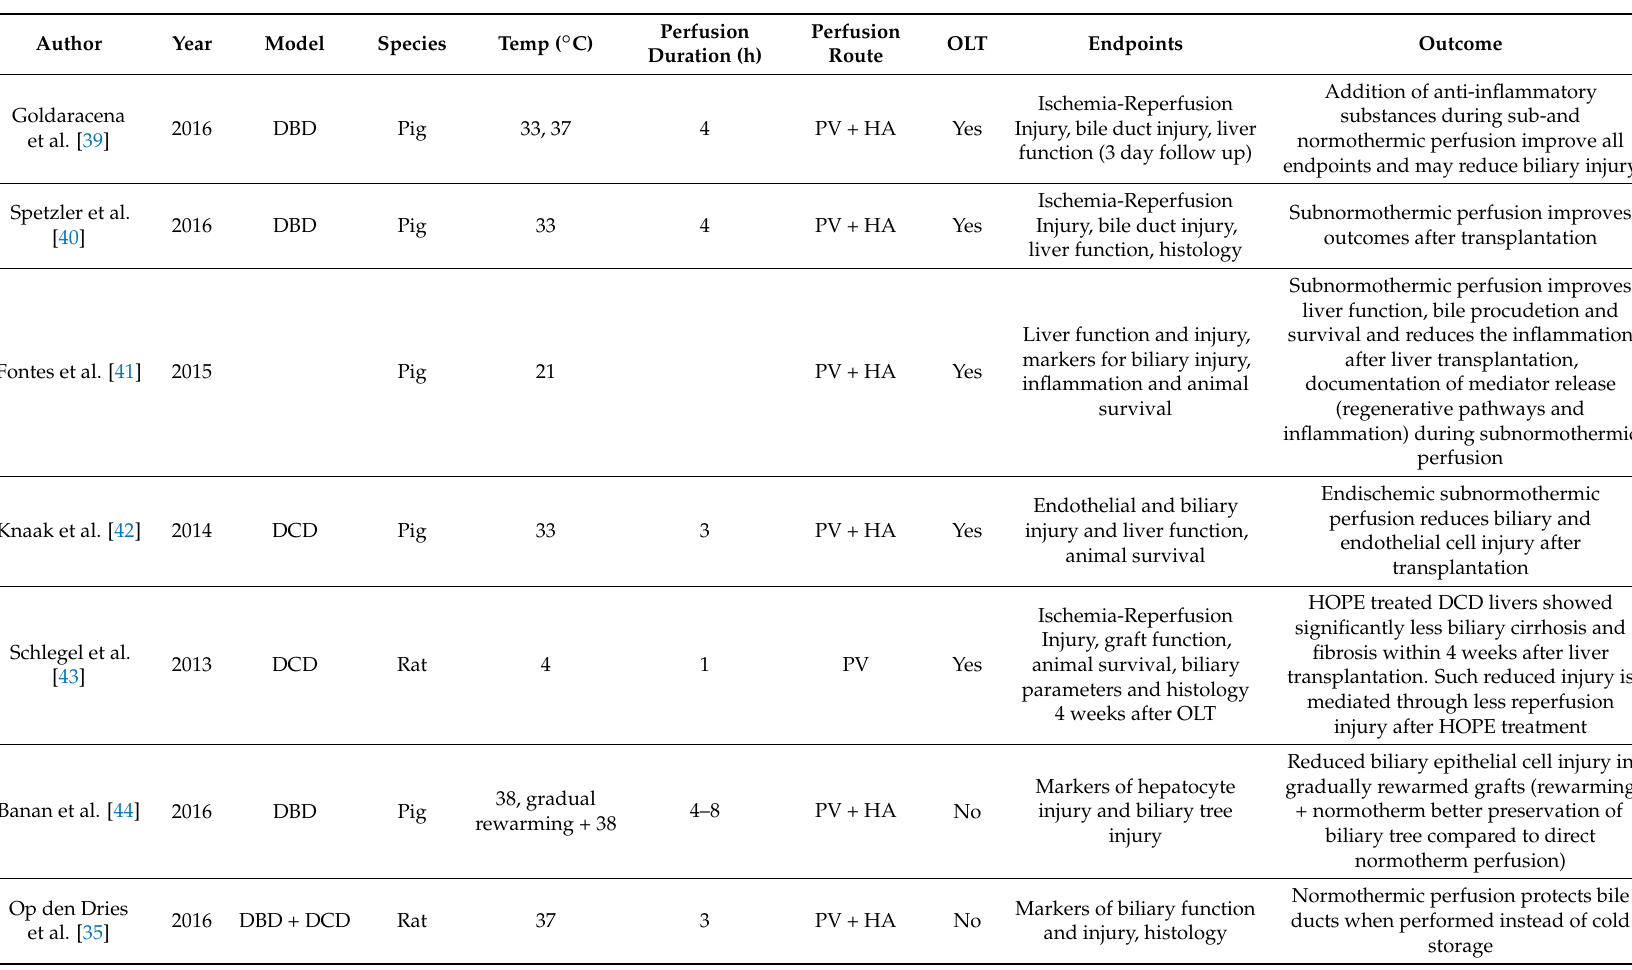
Table 1. Experimental studies analyzing the impact of machine perfusion on the biliary tree between